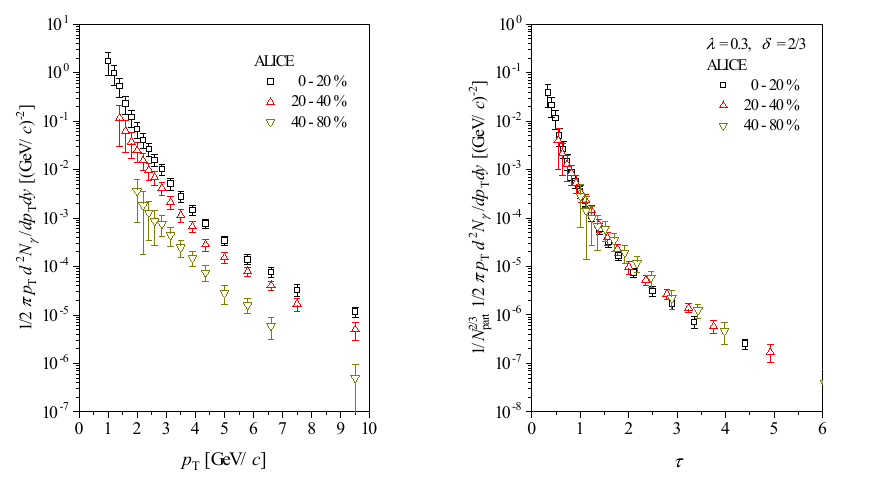
Figure 4. Illustration of N part geometrical scaling of the (cid:13) yields in heavy ion collisions for di (cid:11) erent centrality classes for ALICE PbPb data. Left panel: transverse momentum spectra of direct photons at three centrality classes: 0-20% (black squares), 20-40% (red up-triangles) 40-80%, (dark green down- triangles). Right panel: scaled spectra for (cid:14) = 2 = 3. Data from Ref. [22].